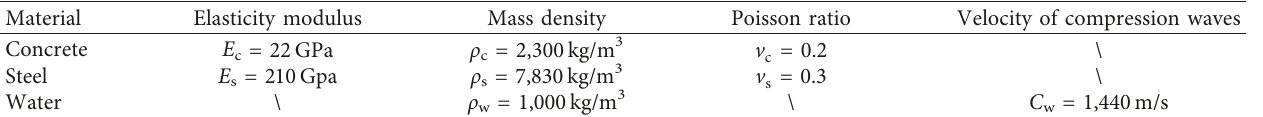
Figure 5: Finite-element model of the hollow pier specimen and water domain: (a) overview; (b) elevation view through a central cutting plane. Table 2: Material